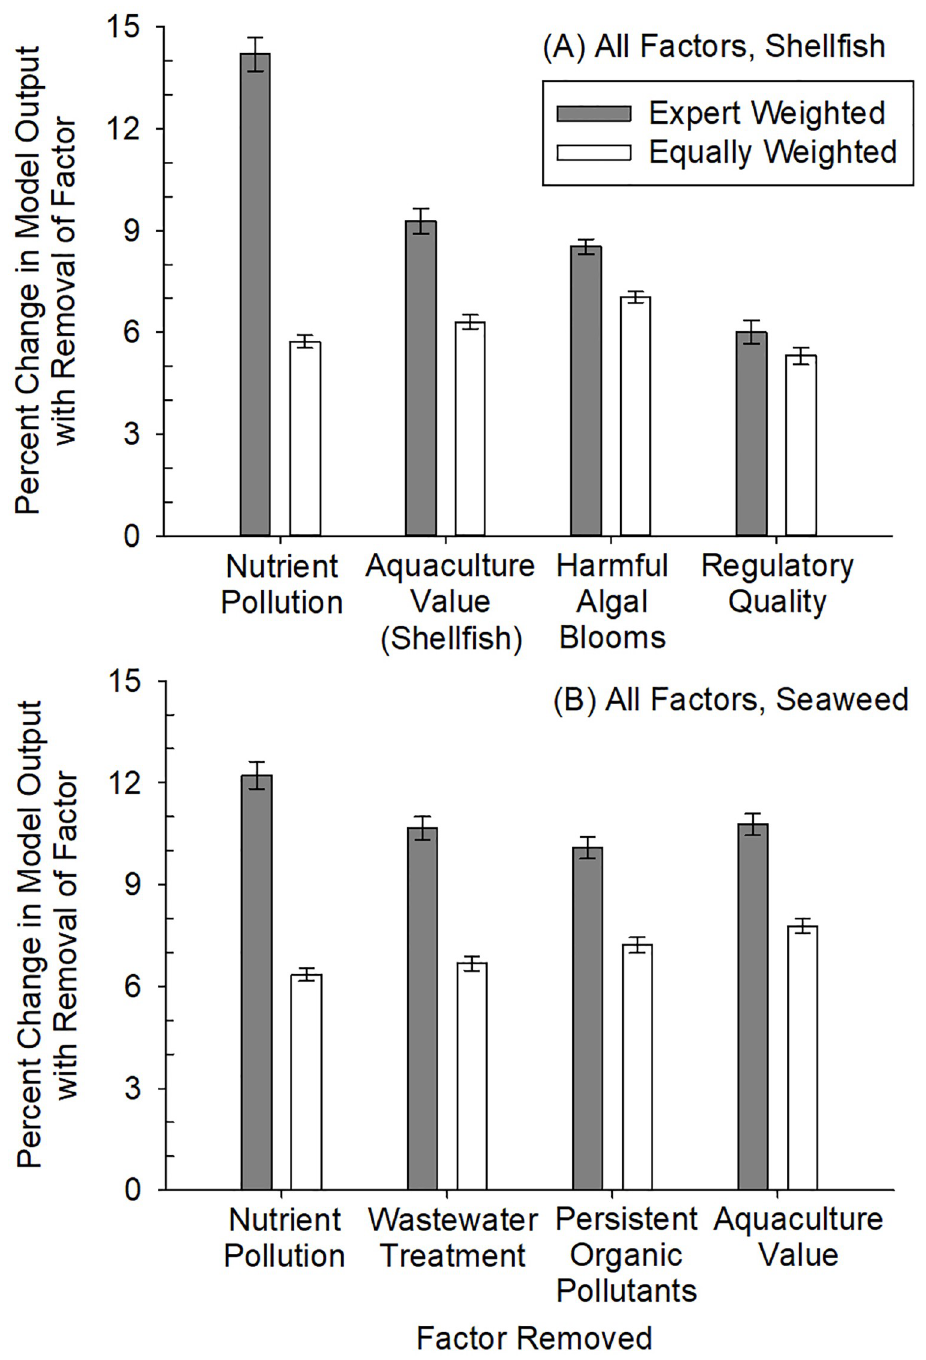
Fig 5. Model sensitivity analysis for (A) shellfish aquaculture RAOI scenario with all environmental, socioeconomic, and human heath factors and (B) seaweed aquaculture RAOI scenario with all factors where: (1) the four factors with the highest weights (stakeholder, expert-weighted RAOI model) were individually removed, (2) the remaining factors were proportionally re-weighted based on the weight of the removed factor, and (3) the percent change in model output was calculated on an marine ecoregion-by-marine ecoregion basis for removal of each factor. The same process was followed in the equally weighted model.